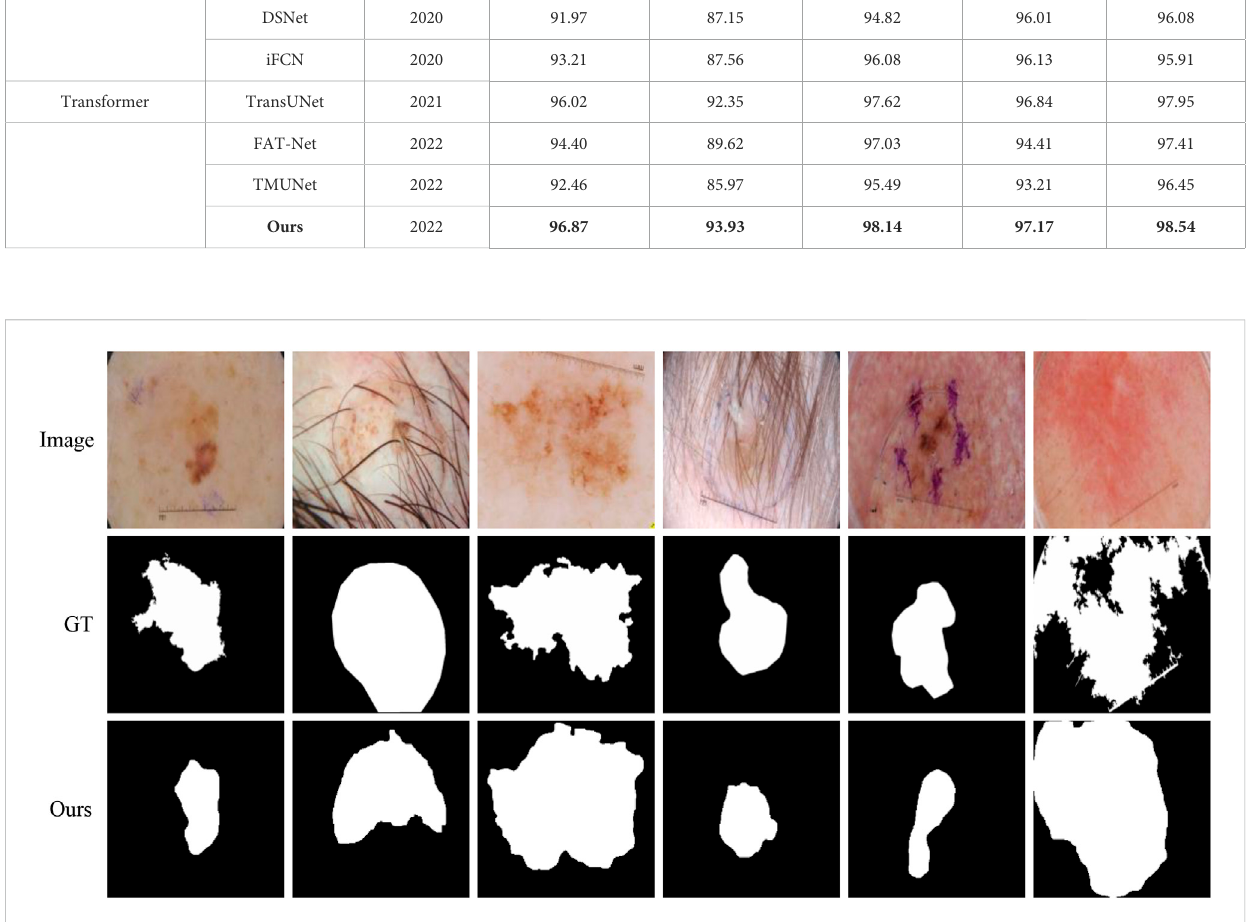
FIGURE 11 Failure examples of the proposed